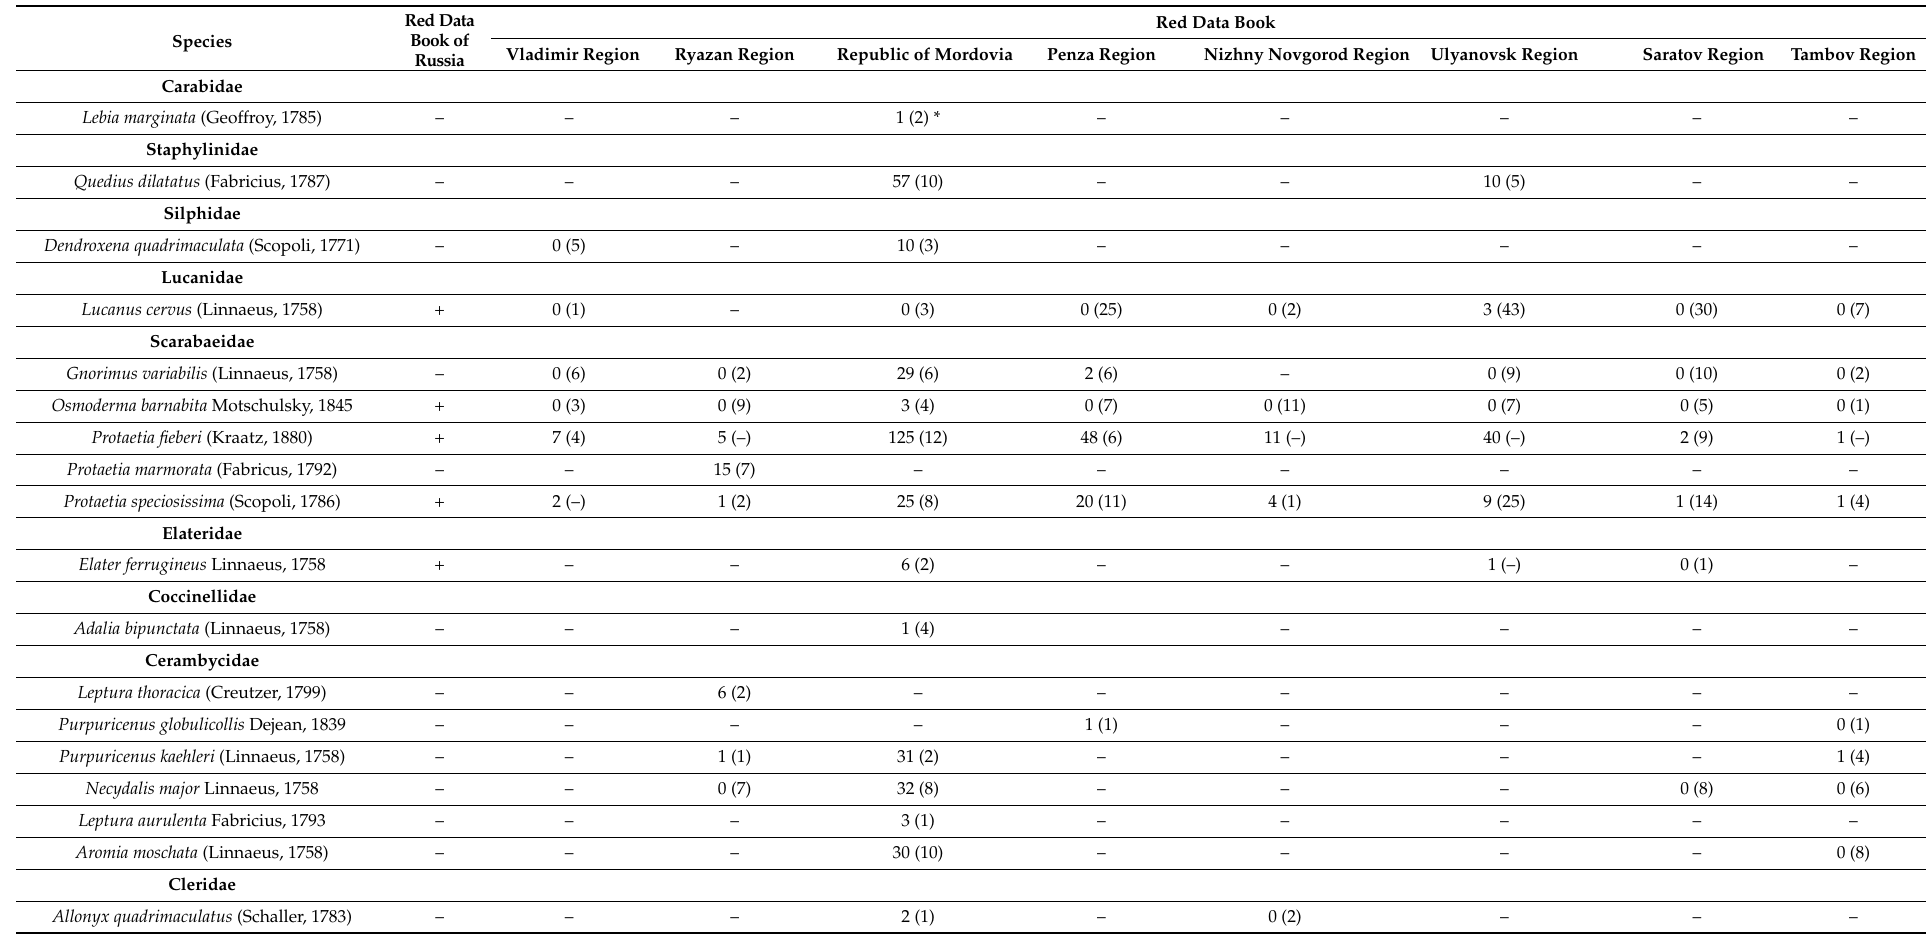
Table 2. Occurrence of rare species (numbers indicate the number of rare species found in the region according to the fermental crown trap records).